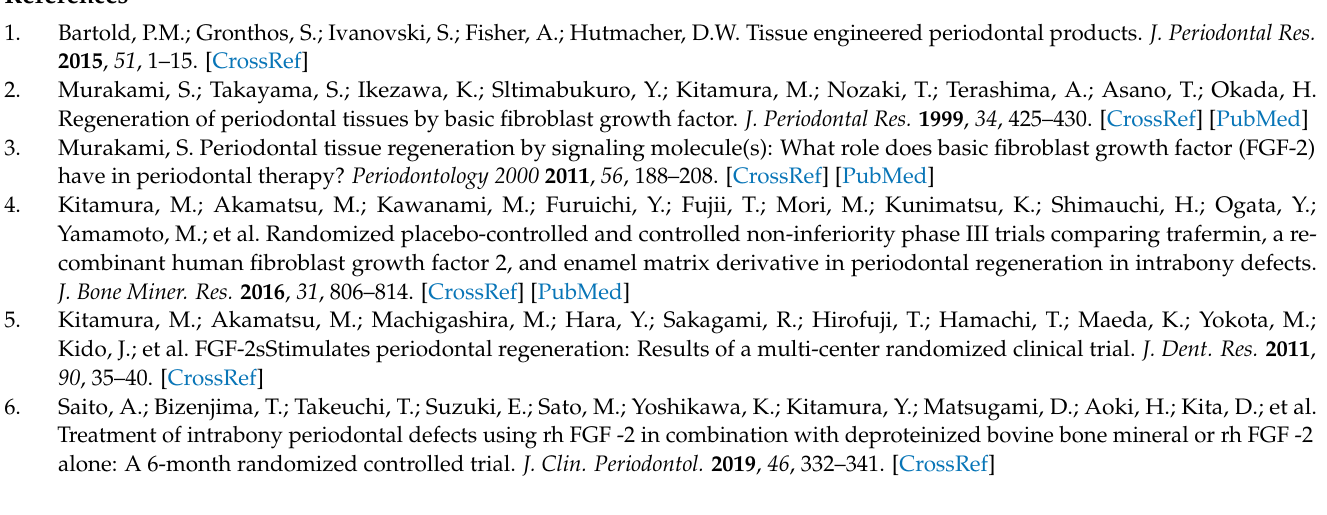
baseline parameters, Table S2: Clinical attachment level (CAL) gains at 4-year follow-up, Table S3: Correlations between variables at baseline (post-IP) and CAL gains at 4-year follow-up, Table S4: Results of multiple regression analysis: rhFGF-2 (control) group, Table S5: Results of multiple regression analysis: rhFGF-2 + DBBM (test)